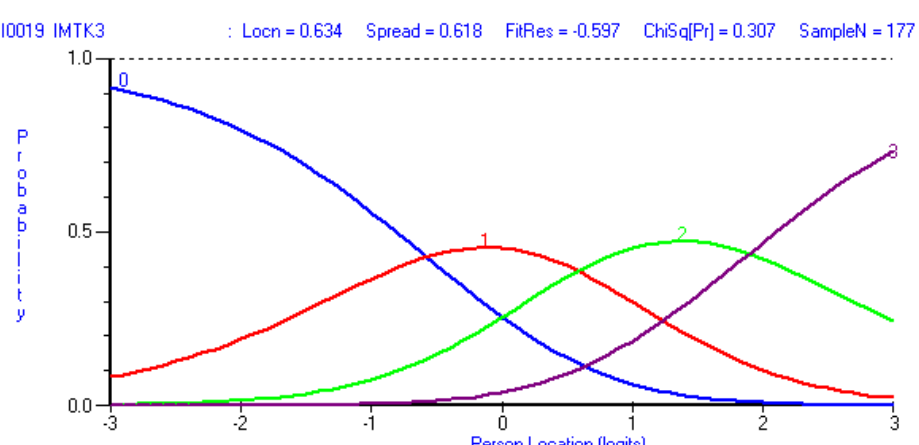
Figure A1. In this figure, evidence of a disordered threshold is presented in I0019 before scoring is adjusted. Category 1 (“corresponds a little”) never has maximal probability and would unlikely be selected by any respondent, regardless of person endorsability (i.e., logit). This suggests that the item categories are not functioning as intended.